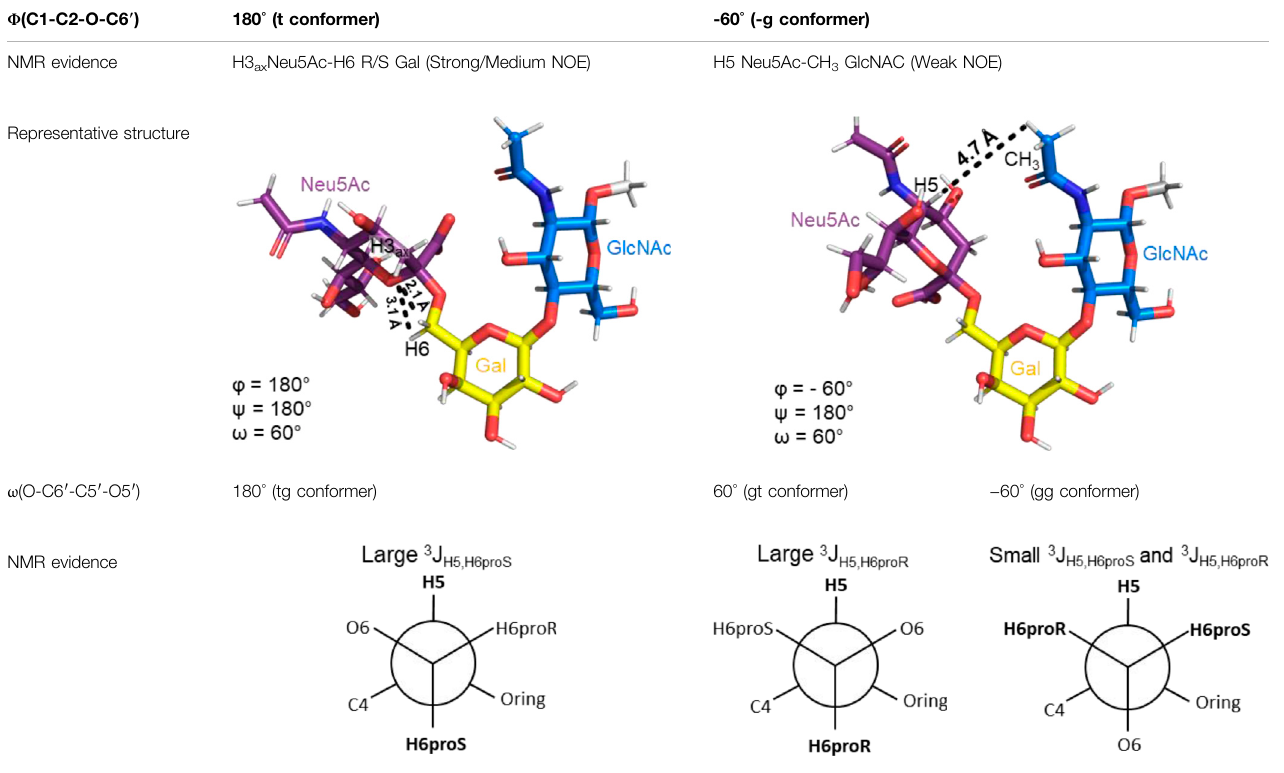
TABLE 2 | Possible conformers of an α 2,6-sialoglycan in solution, represented by 6 ′ SLN (Neu5Ac α 2-6Gal β 1-4GlcNAc). The φ dihedral angle (C1-C2-O-C6 ′ ) can adopt values of 180 ° and − 60 ° (t and -g conformers, respectively), whereas the ω torsion angle (O-C6 ′ -C5 ′ -O5 ’ ) can explore three values, 180 ° , 60 ° , and − 60 ° (tg, gt, and gg conformers,respectively).The ψ dihedralangle(C2-O-C3 ′ -H3 ′ )remainsstableataround180 °